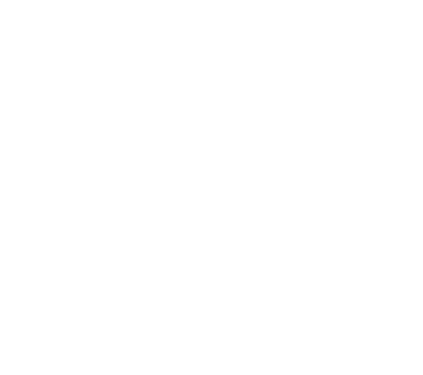
Figure 8 - Example of an India ink black and white illustration showing the autosomal recessive vestigial-antlered phenotype. Original drawing by Edith M. Wallace. The picture was selected by clicking the item in the option list shown on the right after pressing the command button “mutations b(lack)/w(hite).”